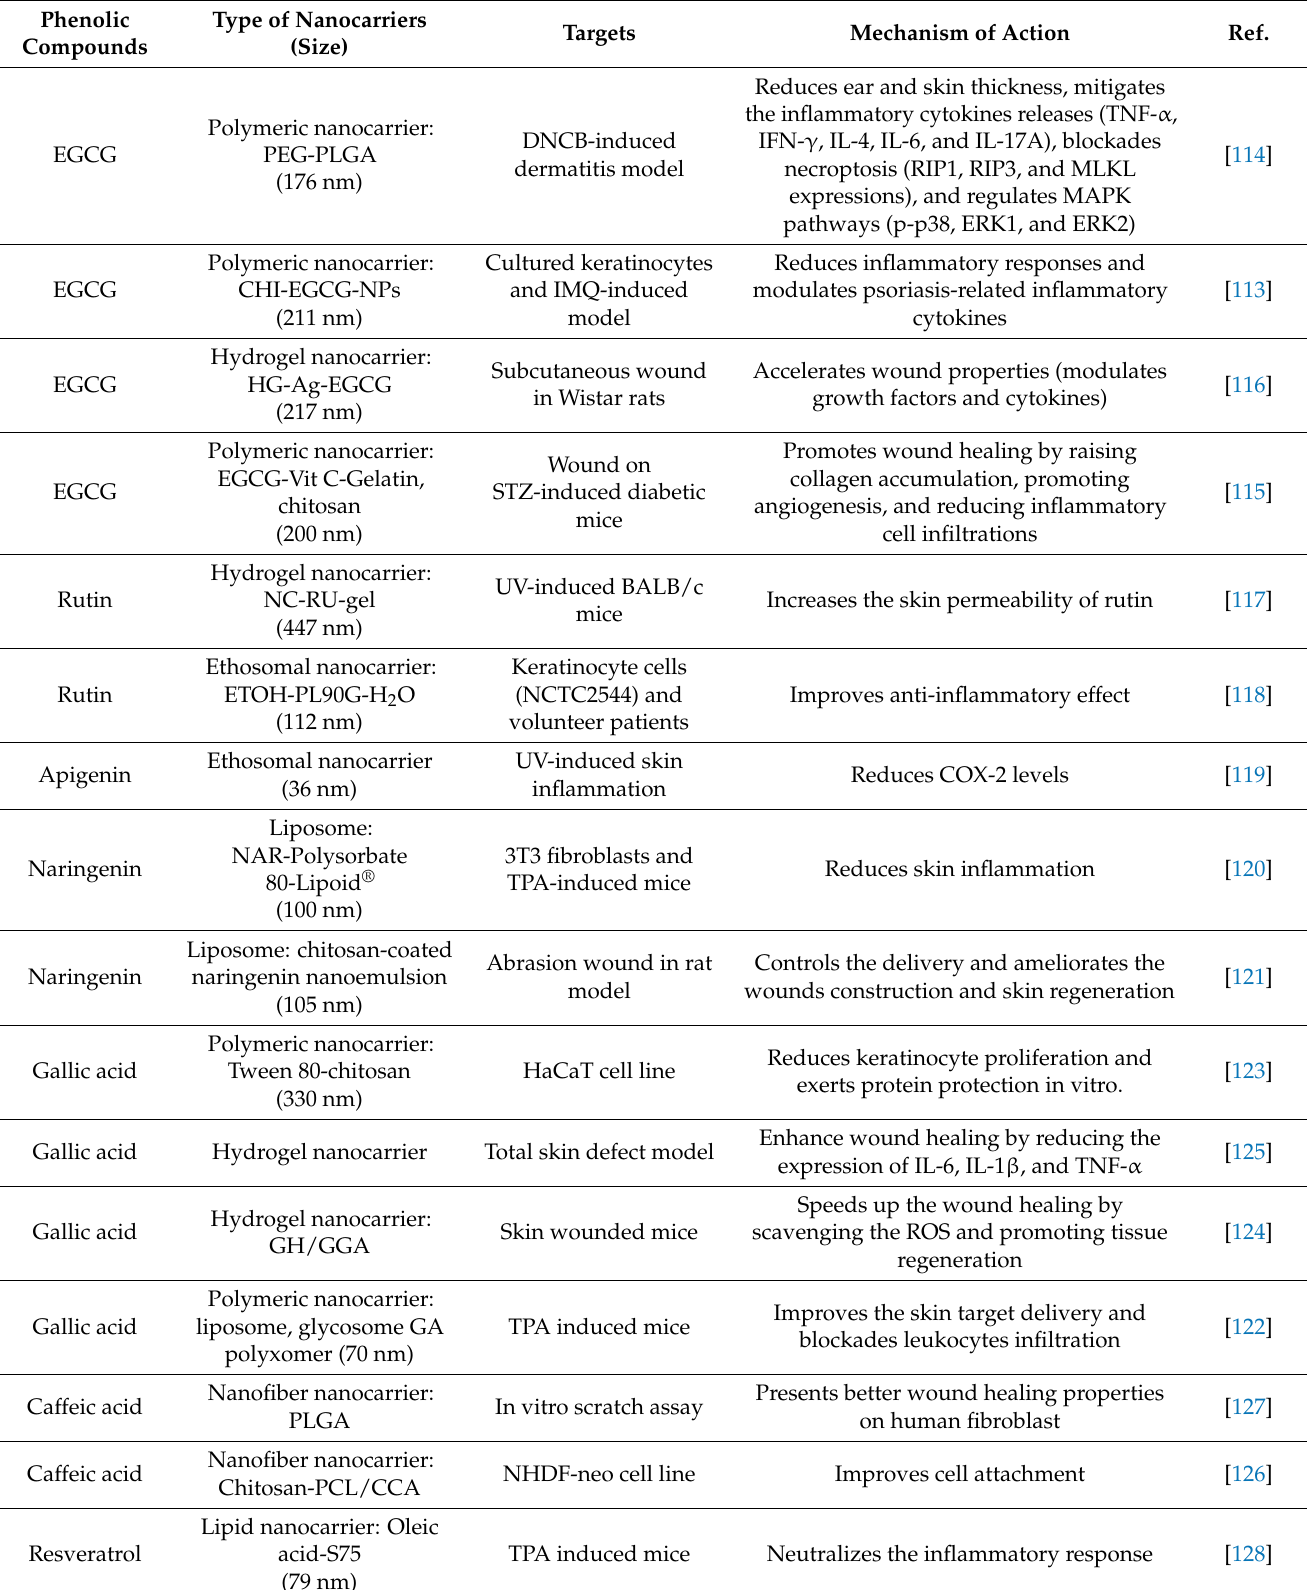
Table 2. Application of phenolic-loaded nanocarriers in skin